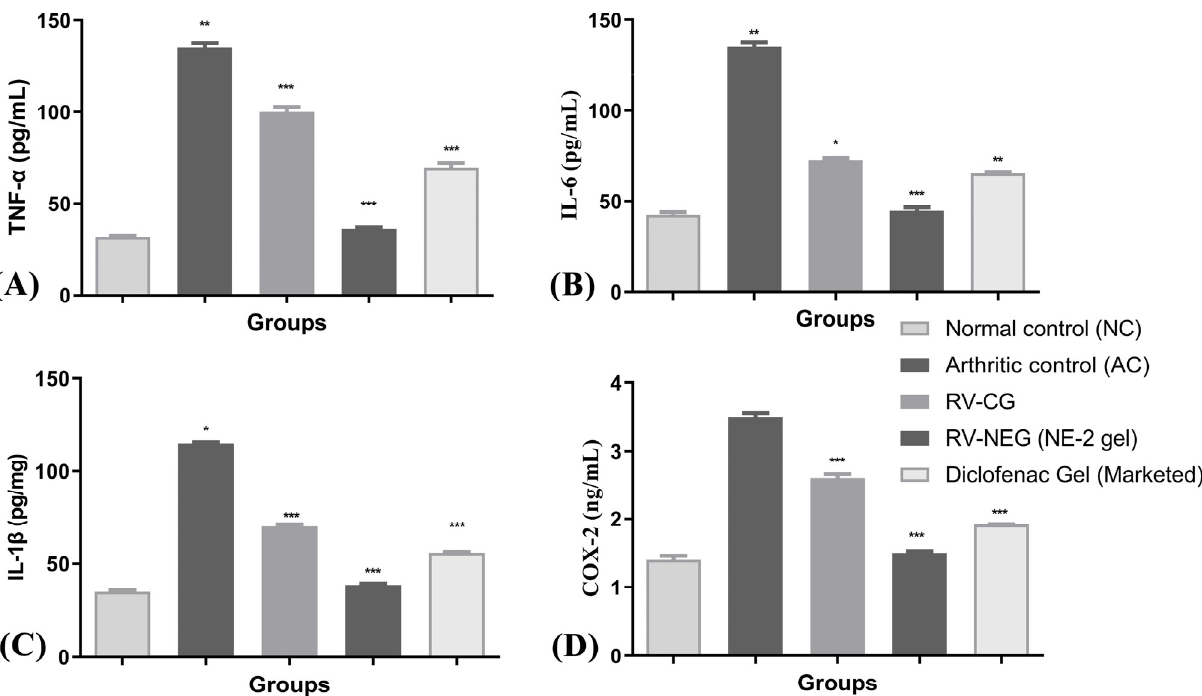
Figure 7. Assessment of arthritis via modulation of pro-inflammatory mediators among different arthritic treatment groups vs. arthritic control. ( A ) Level of TNF- α in joint tissue homogenate. ( B ) Level of IL-6 in joint tissue homogenate. ( C ) Level of IL-1 β and ( D ) level of COX-2 in joint tissue homogenate. NC, normal control, AC = arthritic control, TNF- α = tumor necrosis factor- α , IL-6 = interleukin-6, IL-1 β = interleukin 1 β , COX-2 = cyclooxygenase-2. The comparisons were made by ANOVA followed by Tukey’s test. * p < 0.05, ** p < 0.01, and *** p < 0.001 were considered as significant.